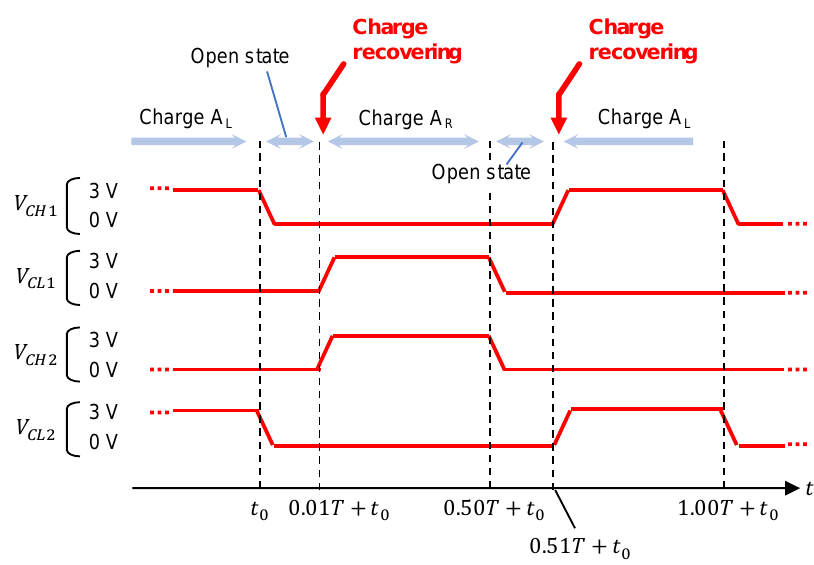
Figure 7. Waveform of control signals (not to scale).